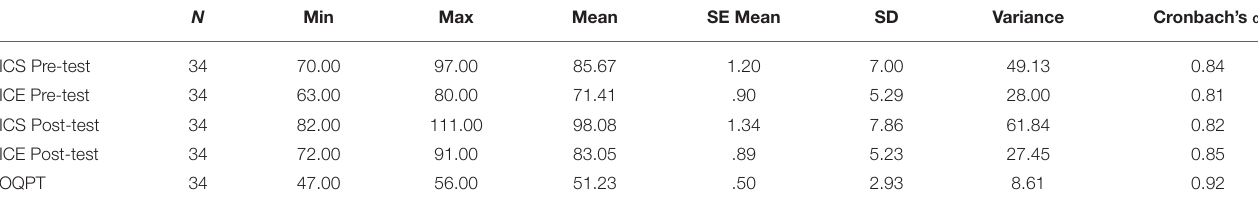
TABLE 2 | Descriptive statistics of the